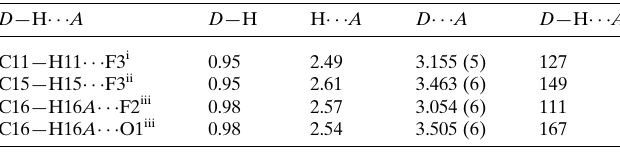
Table 1 Hydrogen-bond geometry (A˚ , (cid:2) ).